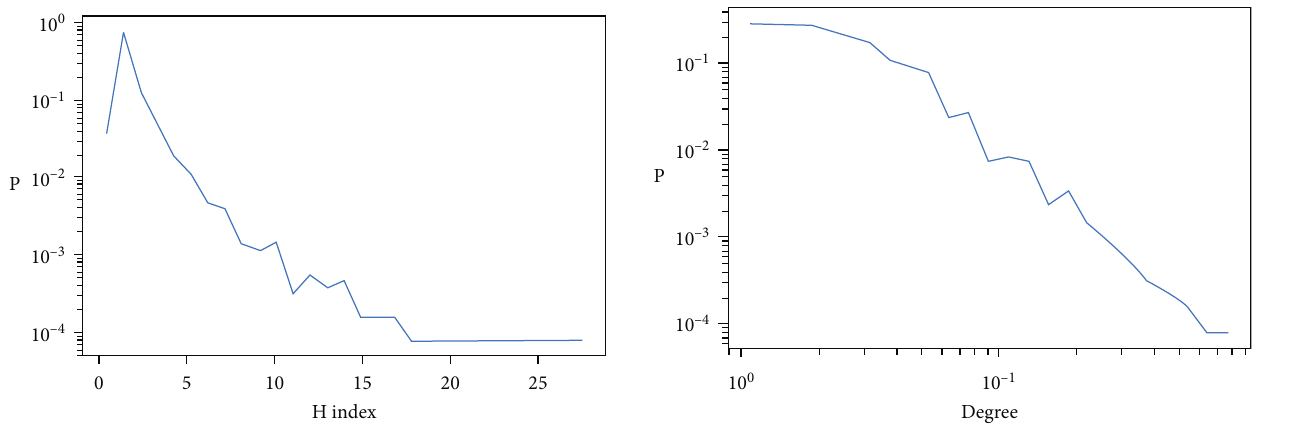
Figure 3: Distribution of H-index. Figure 4: Distribution of degree